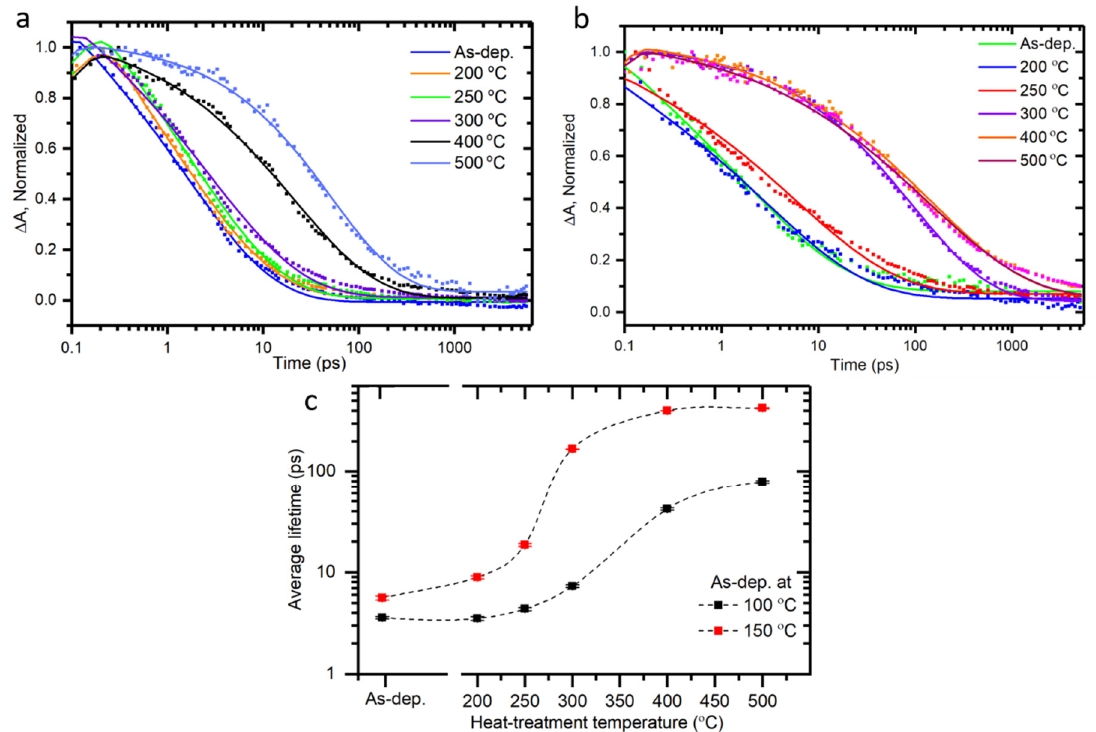
Figure 3. Normalized transient absorption decays profile at 960 nm of samples deposited at ( a ) 100 and ( b ) 150 °C without heat treatment temperature indicated in the plot ( c ) Average lifetimes as function of the heat-treatment temperature for samples deposited at 100 and 150 °C.